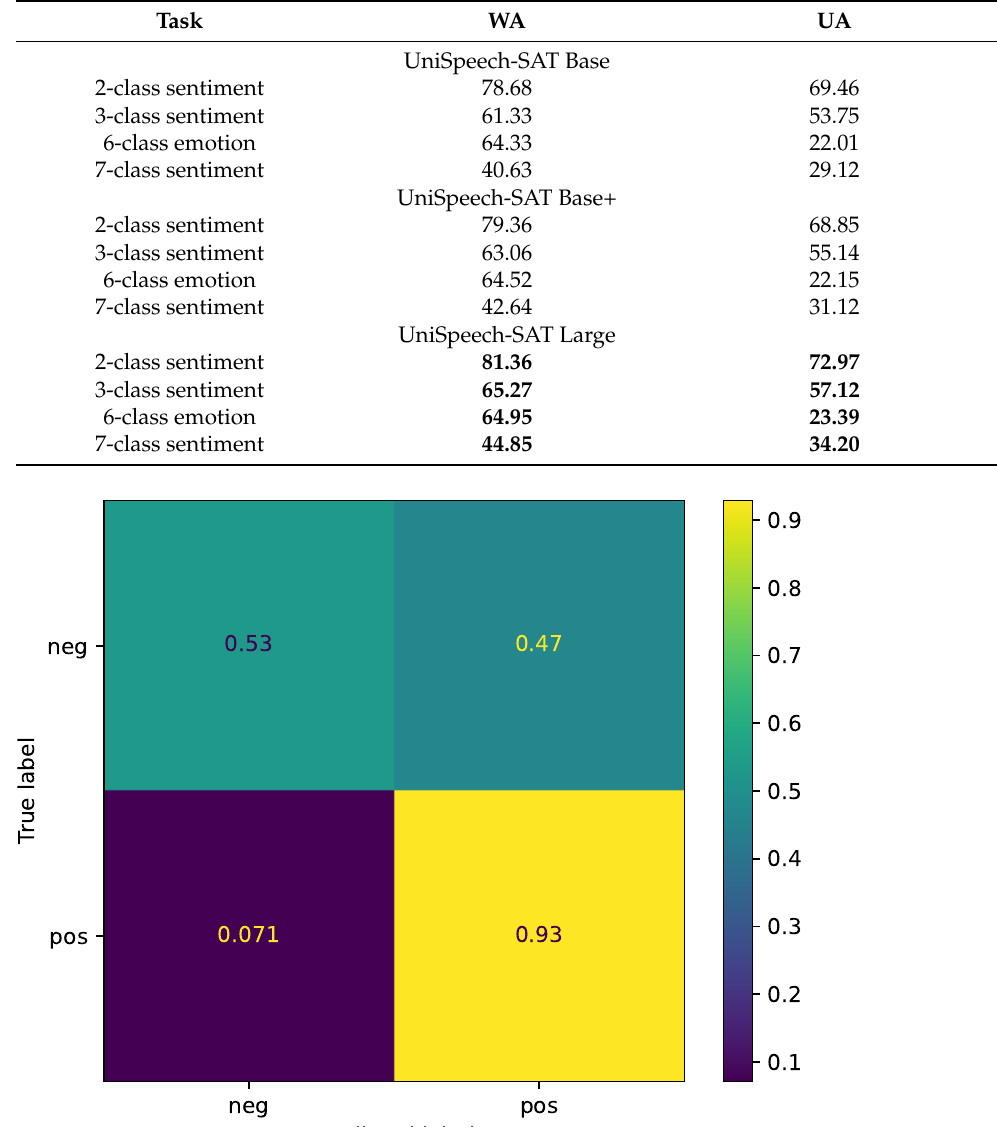
Table 3. Weighted and unweighted accuracies (WA and UA) for sentiment analysis and emotion recognition tasks using the MOSEI dataset; Bolds indicate the highest scores.